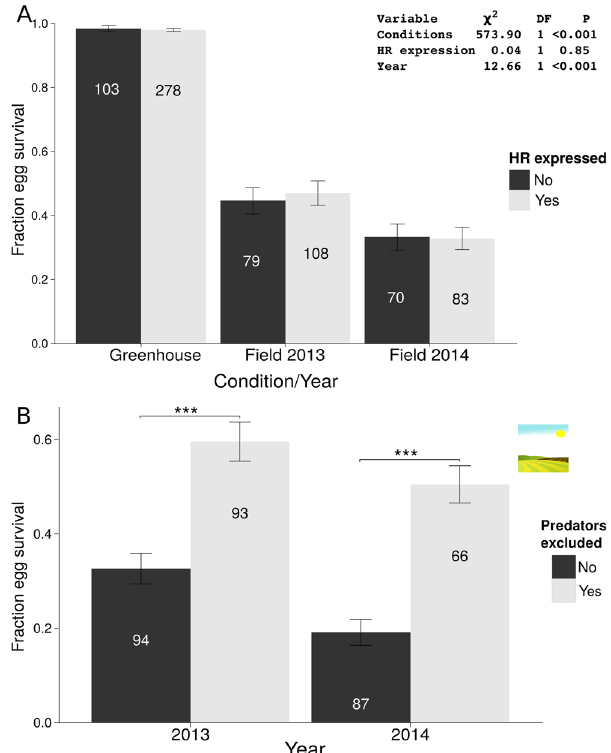
Figure 3. Effect of HR expression on survival of clustered P . brassicae eggs (mean ± SE) laid on B . nigra plants under greenhouse and field conditions (for 2013 and 2014). ( A ) The numbers within each bar represent the numbers of tested plants. The differences in egg survival until larval hatching between HR expressing (light grey) and non-HR expressing plants (dark grey) are not significant, GLM, family = quasibinomial. Differences between greenhouse and field conditions and between both years of field experiments are indicated by asterisks above the horizontal lines, GLM, family = quasibinomial. ( B ) Effect of predator/parasitoid exclusion on survival of clustered P . brassicae eggs (mean fraction ± SE) laid on B . nigra plants in the field. Plants were either covered with a fine mesh during the egg phase (predators excluded – light grey) or left uncovered (predators included – dark